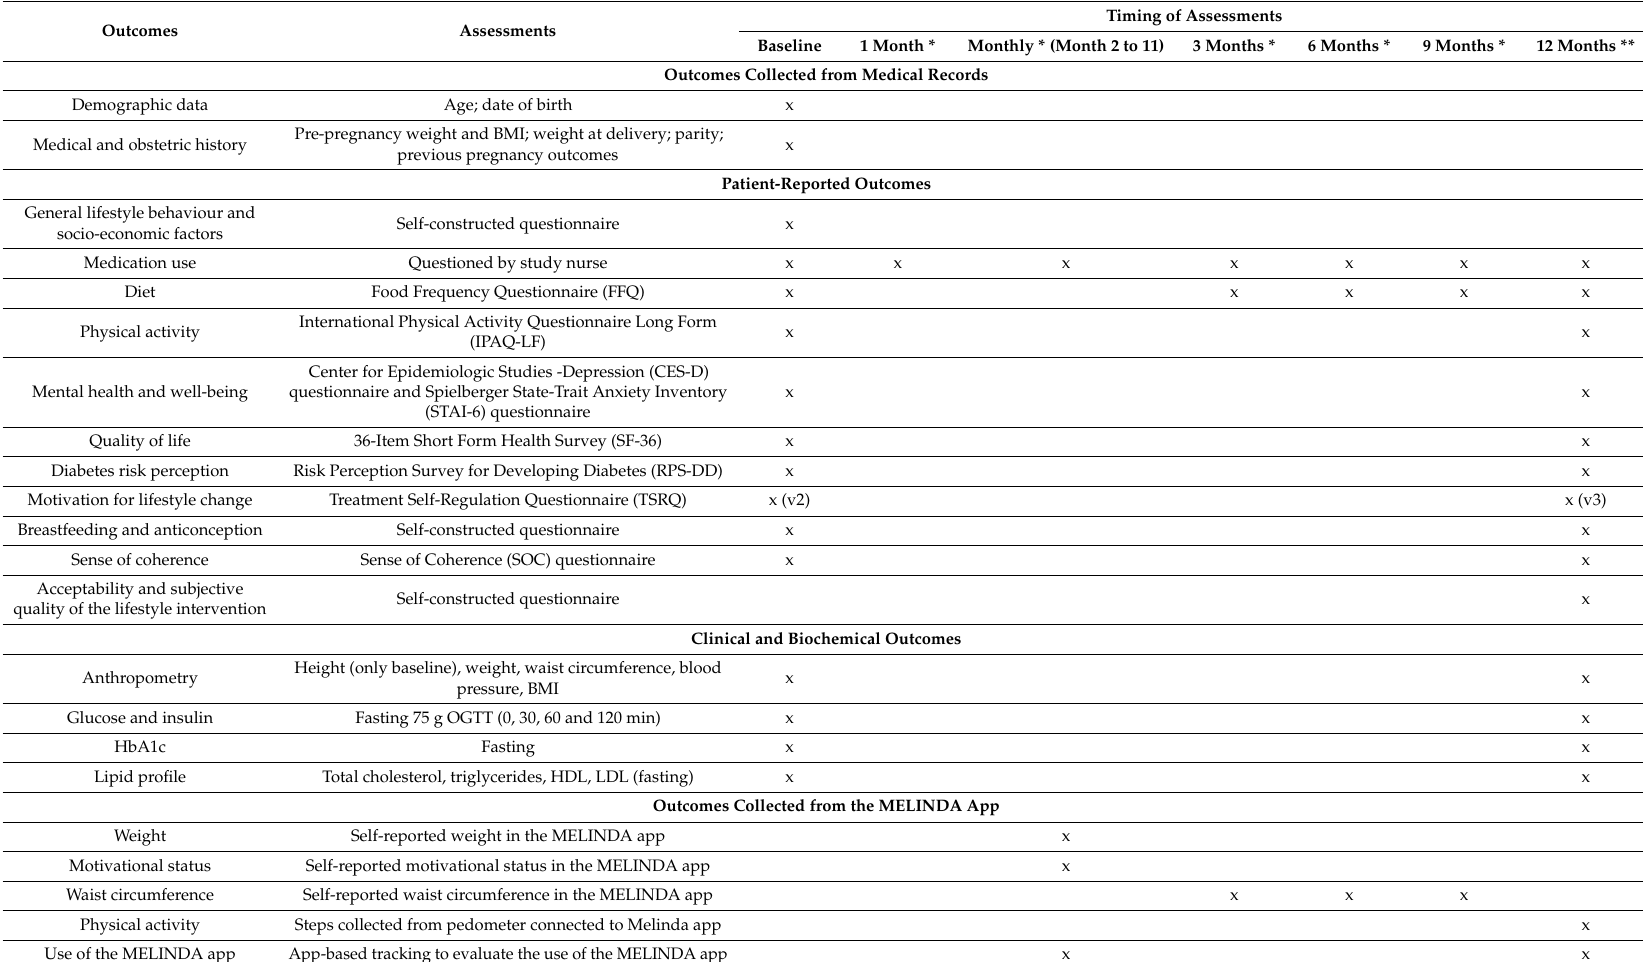
Table 1. Data collection procedures in the MELINDA